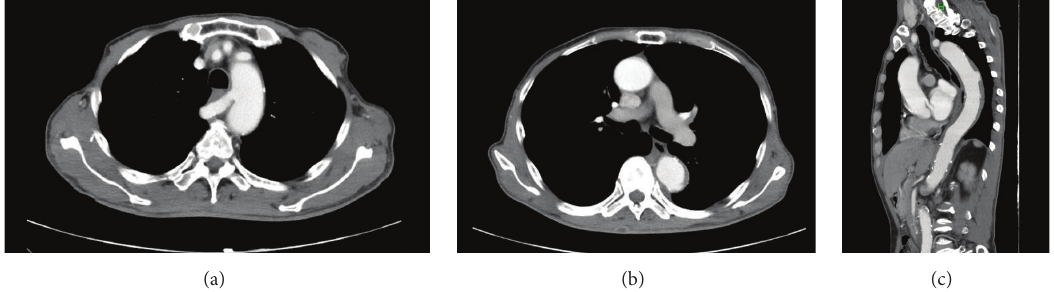
Figure 2: Contrast-enhanced CT findings after onset. (a) Horizontal cross section. False lumen thrombosis was observed. No changes in the origin of the right subclavian artery were noted. (b) Horizontal cross section. (c) Coronal cross section. The emergence of ULP in the descending aorta was